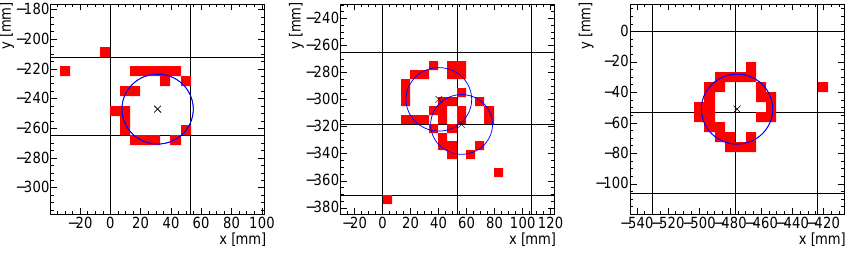
Figure 2. Reconstructed rings from detected Cherenkov photons on the HADES RICH MAPMT plane; zoom-in views of single event displays. Left: Signature of one electron. Center: Two rings from an electron pair with an opening angle α ∼ 2 ◦ . Right: Only one ring can be reconstructed for pair opening angles α → 0 ◦ .